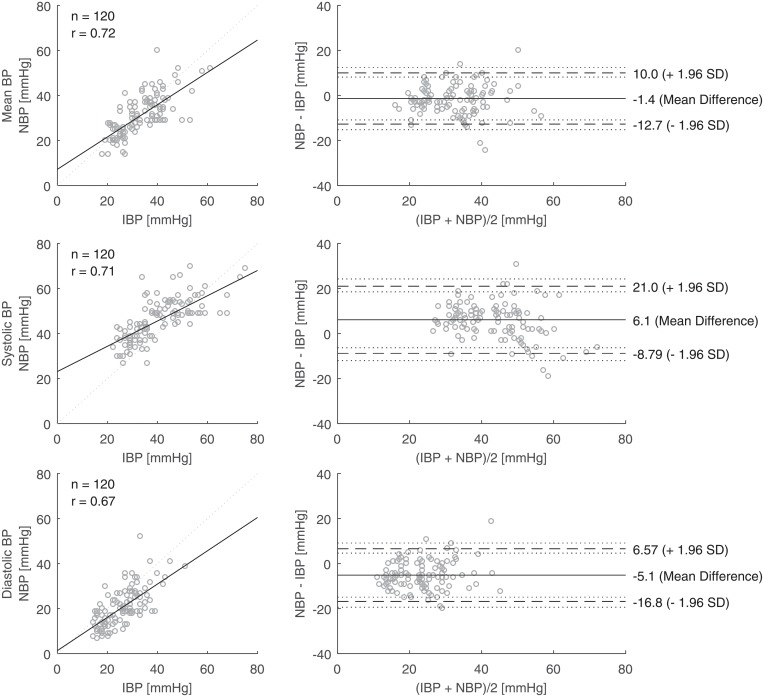
Linear regressions (left; dotted line: Line of equality; r: Pearson correlation coefficient) and Bland-Altman plots (right; dashed lines: Limits of agreement; dotted lines: Confidence intervals) for pairs (n = 120) of invasively (IBP) and non-invasively measured blood pressure (NBP) readings in the first weeks of life obtained from preterm infants born below 28 weeks of gestation.